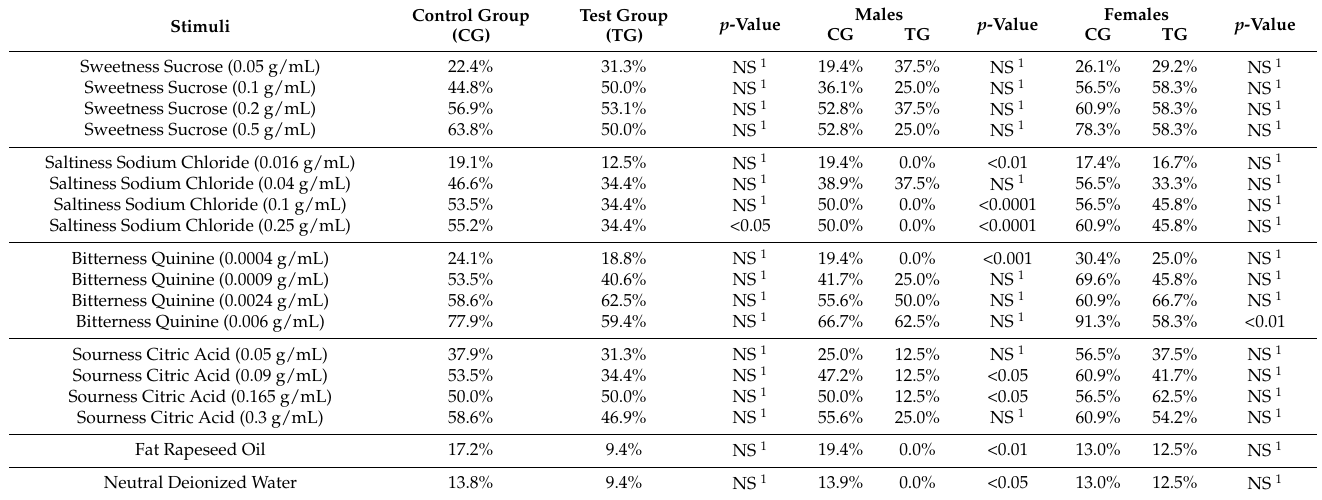
Table 3. Taste stimuli test: percentage of correct answer in the study groups.